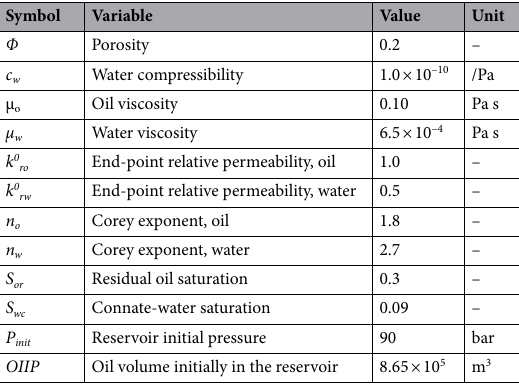
Table 2. Reservoir and fluid properties for the base